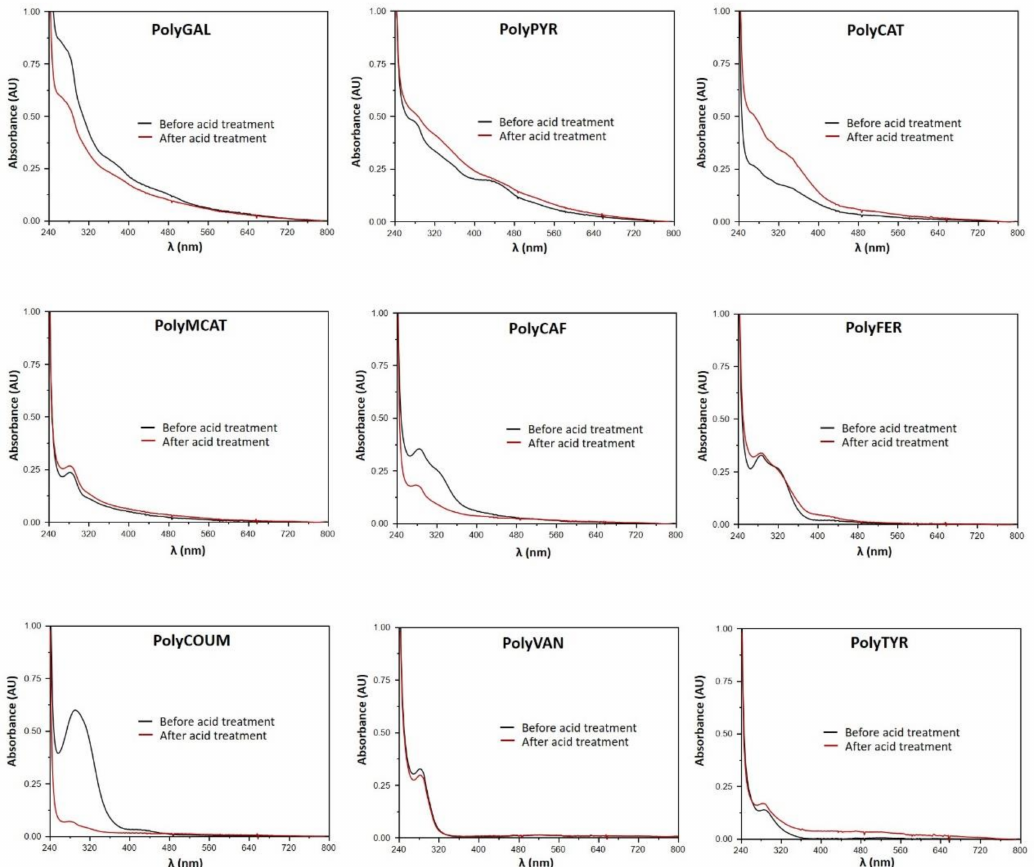
Figure 3. UV–vis spectra of 0.01 mg / mL methanolic solutions (from dilution of a 0.33 mg / mL solution in DMSO) of the enzymatically synthesized phenolic polymers before ( black line ) and after ( red line ) the acid